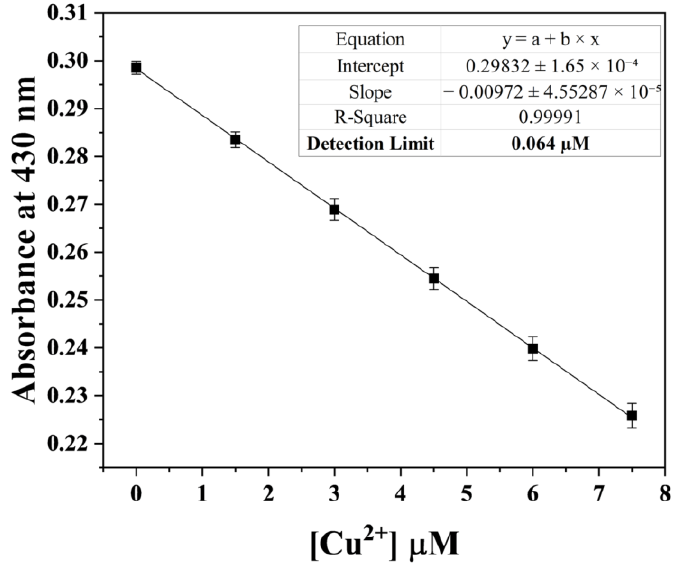
Figure 4. Calibration curve for Cu 2+ analysis using HDHT plotted against absorbance at 430 nm ( n = 3).